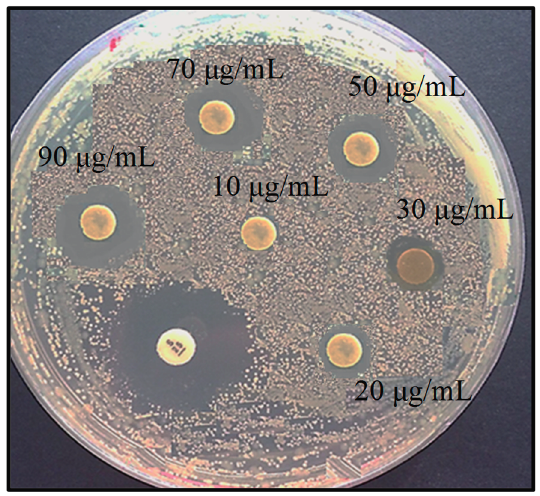
Figure 8. Inhibition zone of the bio-formed Ag-NPs solution against E. coli pathogen.